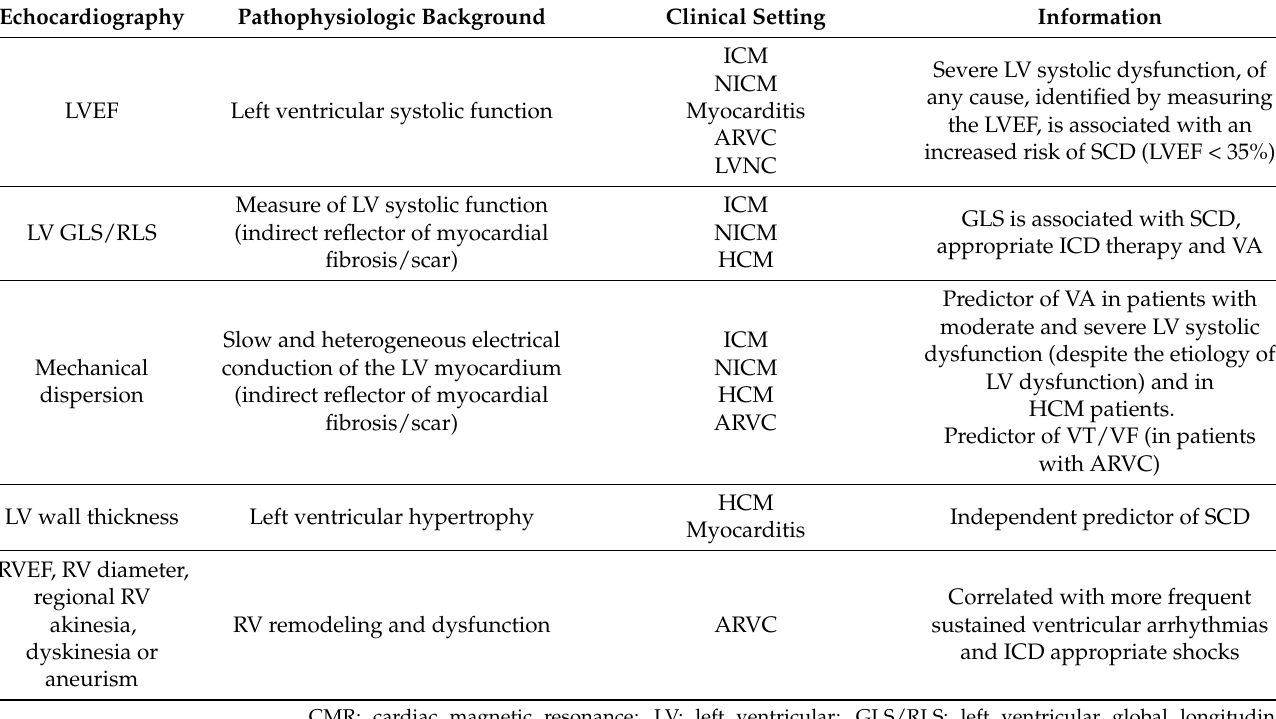
Table 2. Echocardiographic parameters associated with an increased risk of malignant ventricular